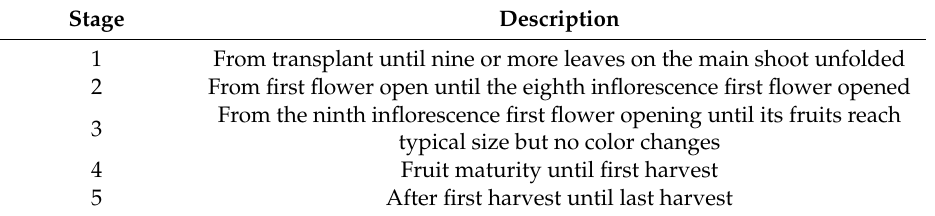
Table 6. Description of the tomato developmental stages used as the guide for sampling collection.